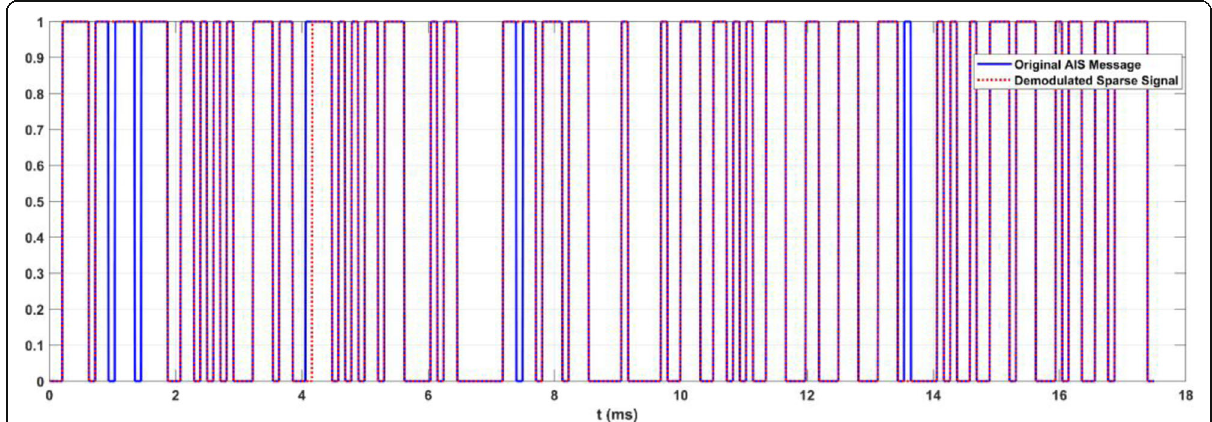
Fig. 8 The demodulated sparse signal: binary signal demodulated from the sparse signal